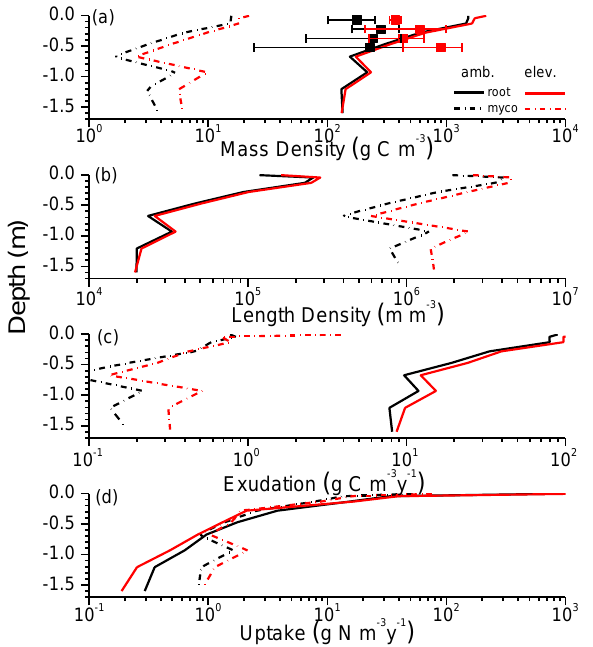
Fig. 8. Root and mycorrhizal (a) mass and (b) length density, + NO − (c) NH + uptake and (d) C exudation measured (sym- 4 3 bols) and modelled (lines) vs. depth during 2001 under ambient ( ∼ 370µmolmol − 1 ) vs. elevated ( ∼ 550µmolmol − 1 ) C a without N fertilizer at the ORNL FACE experiment. Measured data from Iversen et al. (2008), with error bars representing standard errors from replicated measurements ( n = 2).